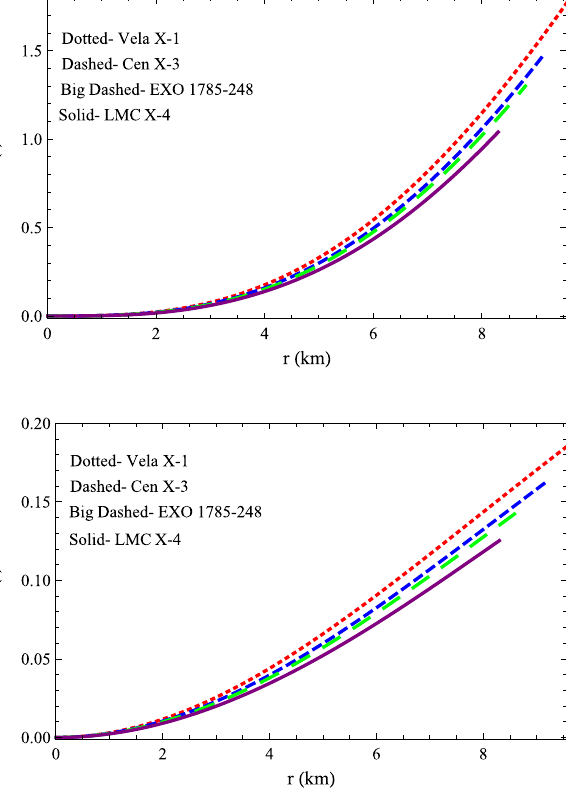
Fig. 5 Mass function (above) and compactness parameter (below) vs the radial coordinate r corresponding to numerical values of constants given in Table 2 for four well-known compact